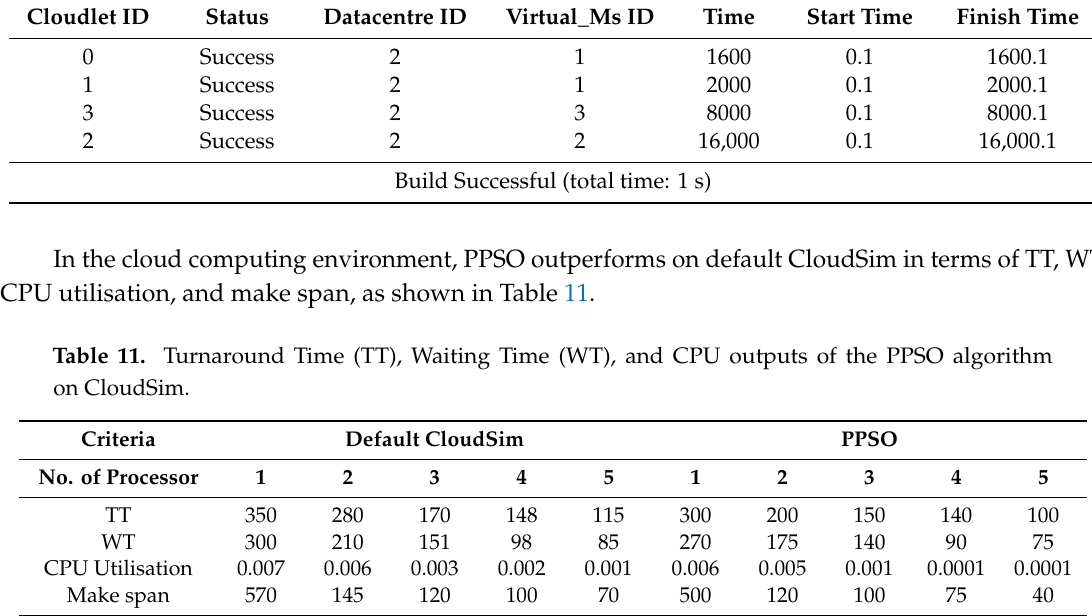
Figure 5. Appl. Sci. 2020 , 10 , x FOR PEER REVIEW